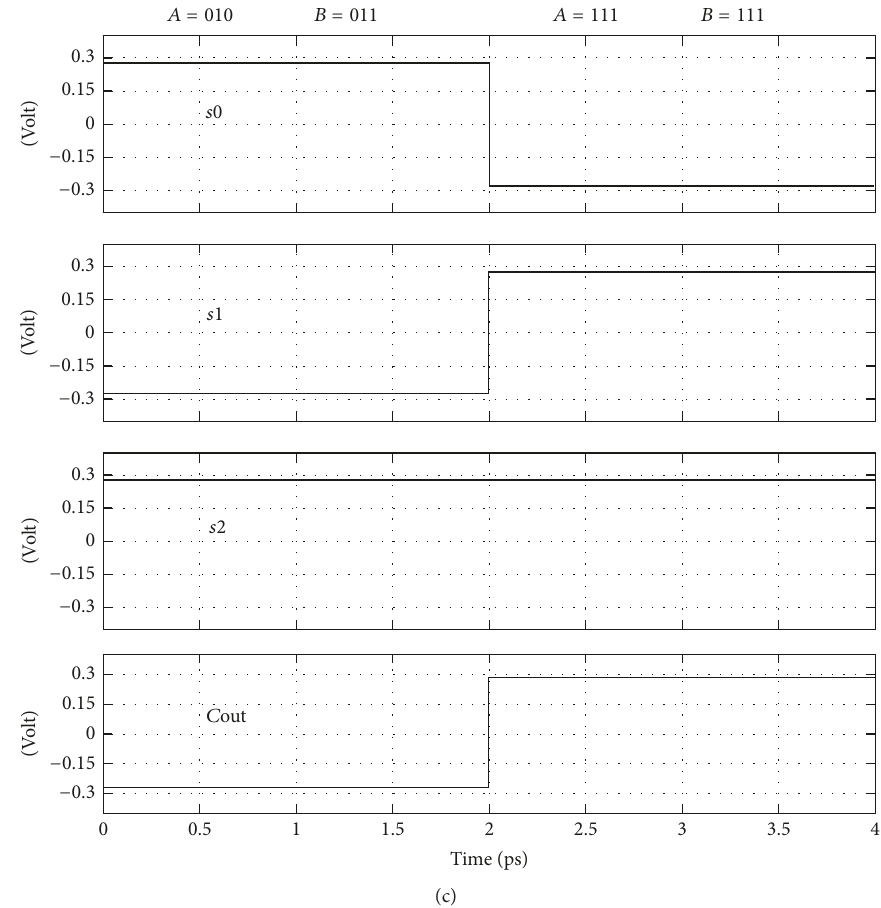
Figure 10: Crossbar architecture of a: (a) half adder implemented using complementary logic. The orange color shows a common back gate for P-type region and the green shows that for N-type region. (b) Single-bit full adder, implemented by the connection of two HAs and an OR gate. (c) Output waveforms of a 3-bit ripple carry adder implemented using complementary logic. In this case, the low and high input values of −0.3 V and +0.3 V are used to encode logic “0” and “1,” respectively.